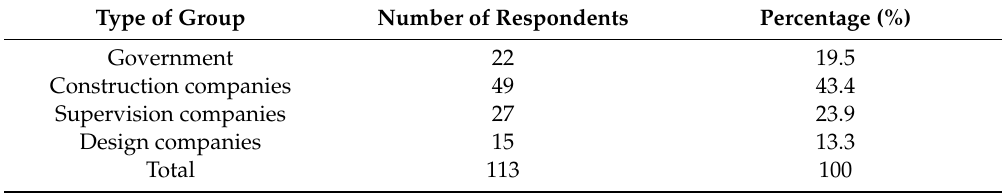
Table 3. The summary of responses in the questionnaire